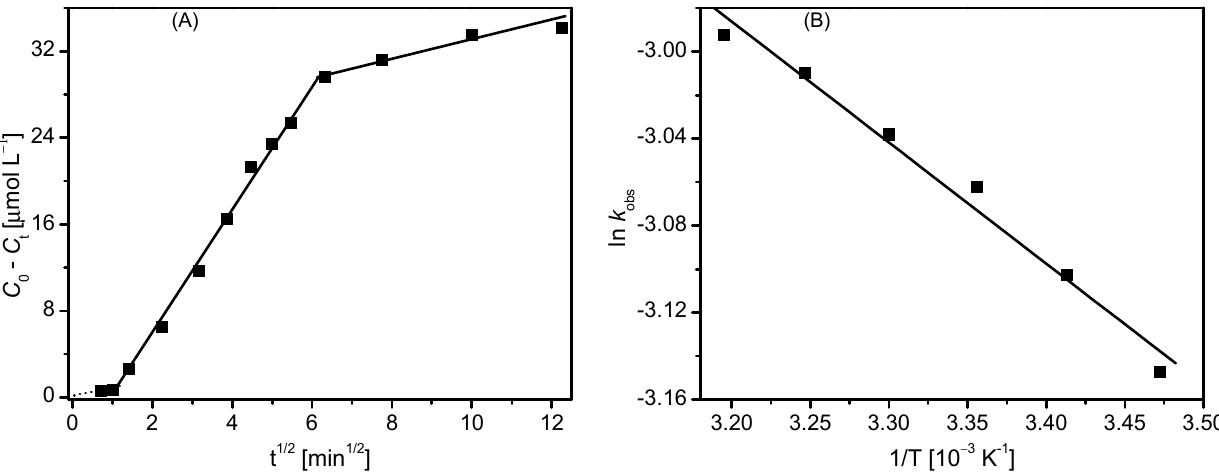
Figure 2. ( A ) Simulation of kinetic data with the intraparticle diffusion model, and ( B ) an Arrhenius plot of lnk obs against 1/T for the photocatalytic degradation of AO in the heterogenous aqueous solution. The lines are the best fits. The activation energy of the photocatalytic degradation was deduced based on the Arrhenius equation.